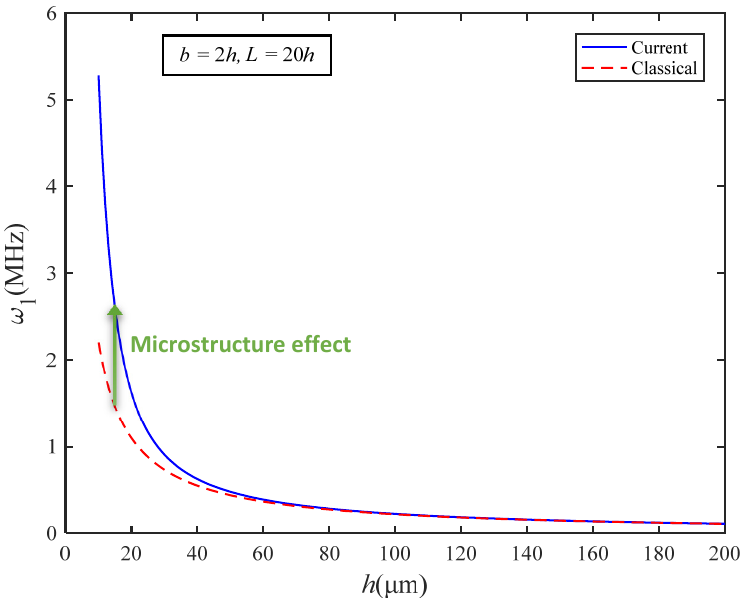
Figure 11. Natural frequency with different MEE-FGM beam thickness (Gradient index n = 5).